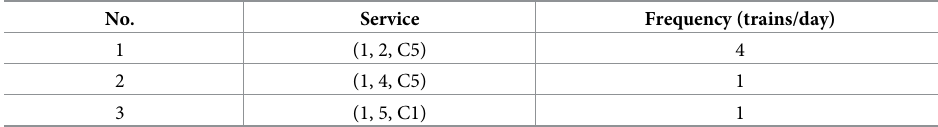
Table 10. Service